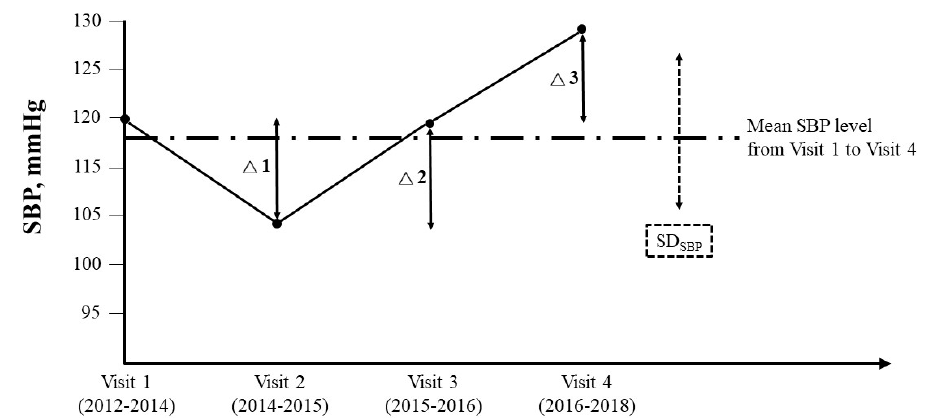
Figure 1. Long-term blood pressure variability (BPV) was assessed by standard deviation and average real variability across 4 visits in the study period (2012–2018). Standard deviation (SD) SBP and average real variability (ARV) SBP were respectively illustrated by dotted and solid lines. ARV SBP is an average of absolute differences between successive systolic blood pressure measurements, and it takes the order of measurements into account (| Δ 1| + | Δ 2| + | Δ 3|)/3).